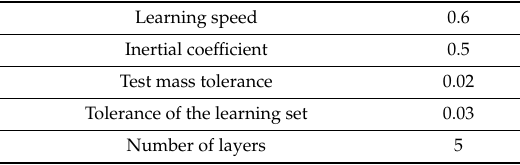
Table 2. Parameters of the Neural Network